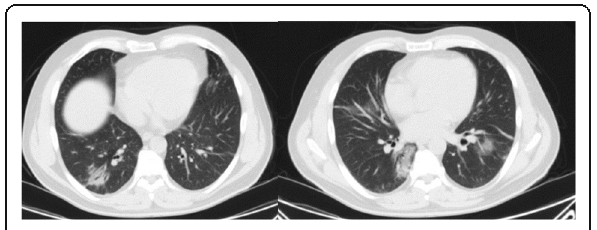
Fig. 11 COVID-19 pneumonia: thin section CT shows mass-like peribronchovascular and subpleural consolidation in lower lobes